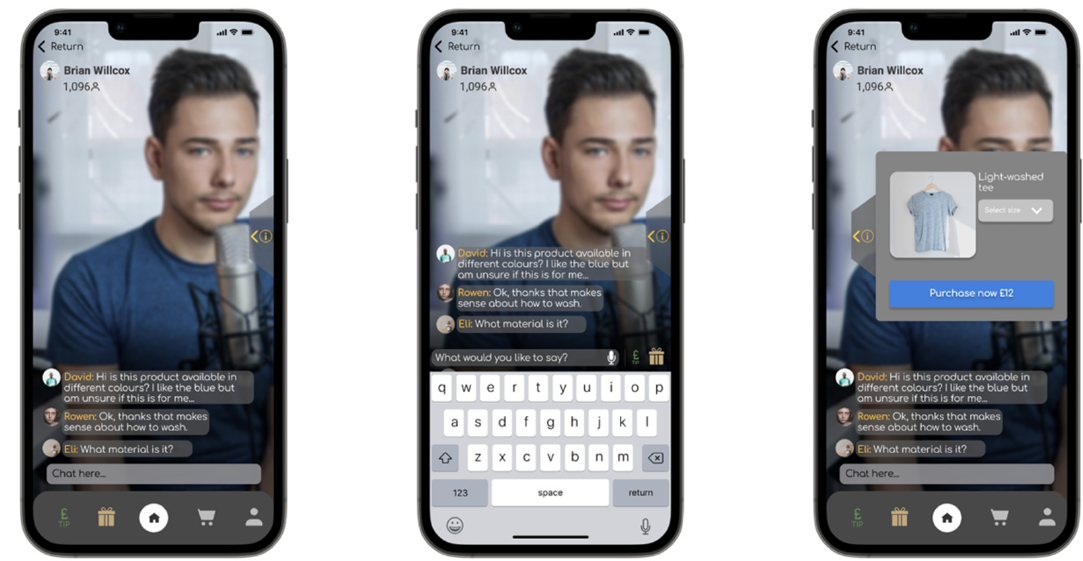
Figure 15. A high-fidelity mock-up of a live stream commerce ‘plug-in’ generated from the Participatory and Co-design workshops, demonstrating chat functions, in Figma.